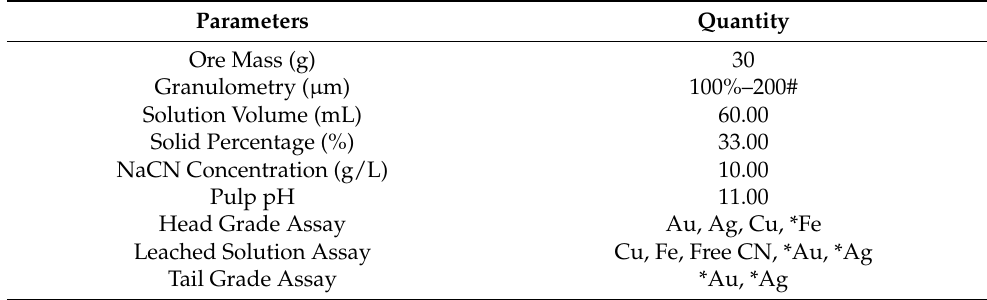
Table 1. Summary of shaker test analytical